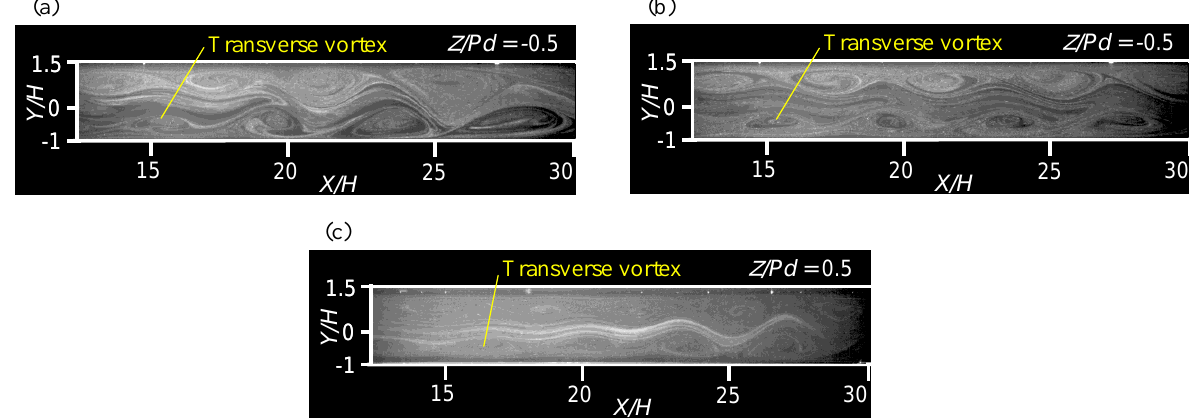
= 36 Hz. (a) Case 1 at Z/P = -0.5 (on SJ d = 0.5 (on VR = 1 d